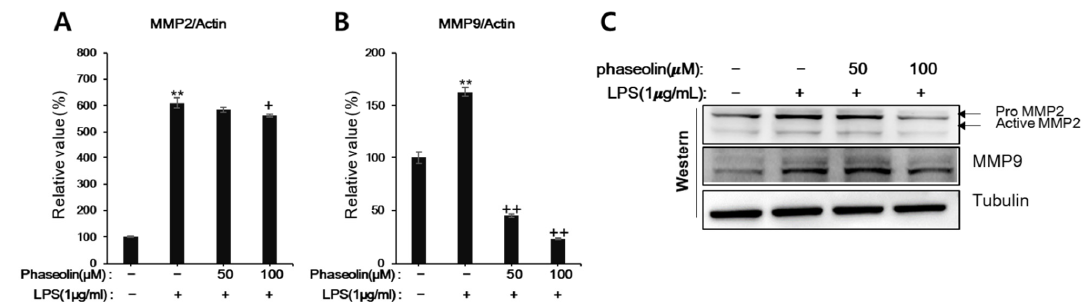
Figure 6. Effects of phaseolin on matrix metalloproteinase (MMP)-9 and MMP-2 expression. RAW 264.7 cells were treated with LPS (1 μ g/mL) alone or LPS + phaseolin (50 or 100 μ M) for 24 h and then MMP-9 and MMP-2 expression was assessed by realtime-PCR ( A , B ) and Western blotting ( C ). ** p < 0.01, vehicle vs. LPS-treated group; + p < 0.05 and ++ p < 0.01, LPS vs. LPS plus phaseolin-treated group.